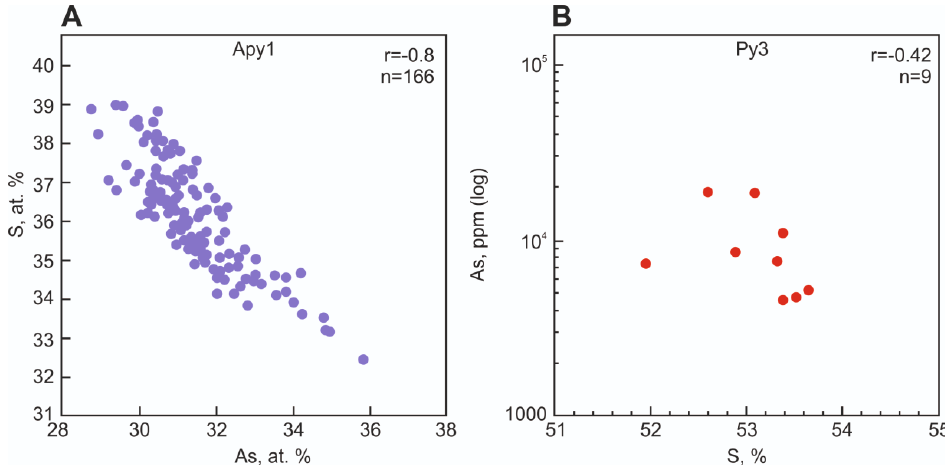
Figure 10. Ratio of As and S in ( A ) Apy1 and ( B )